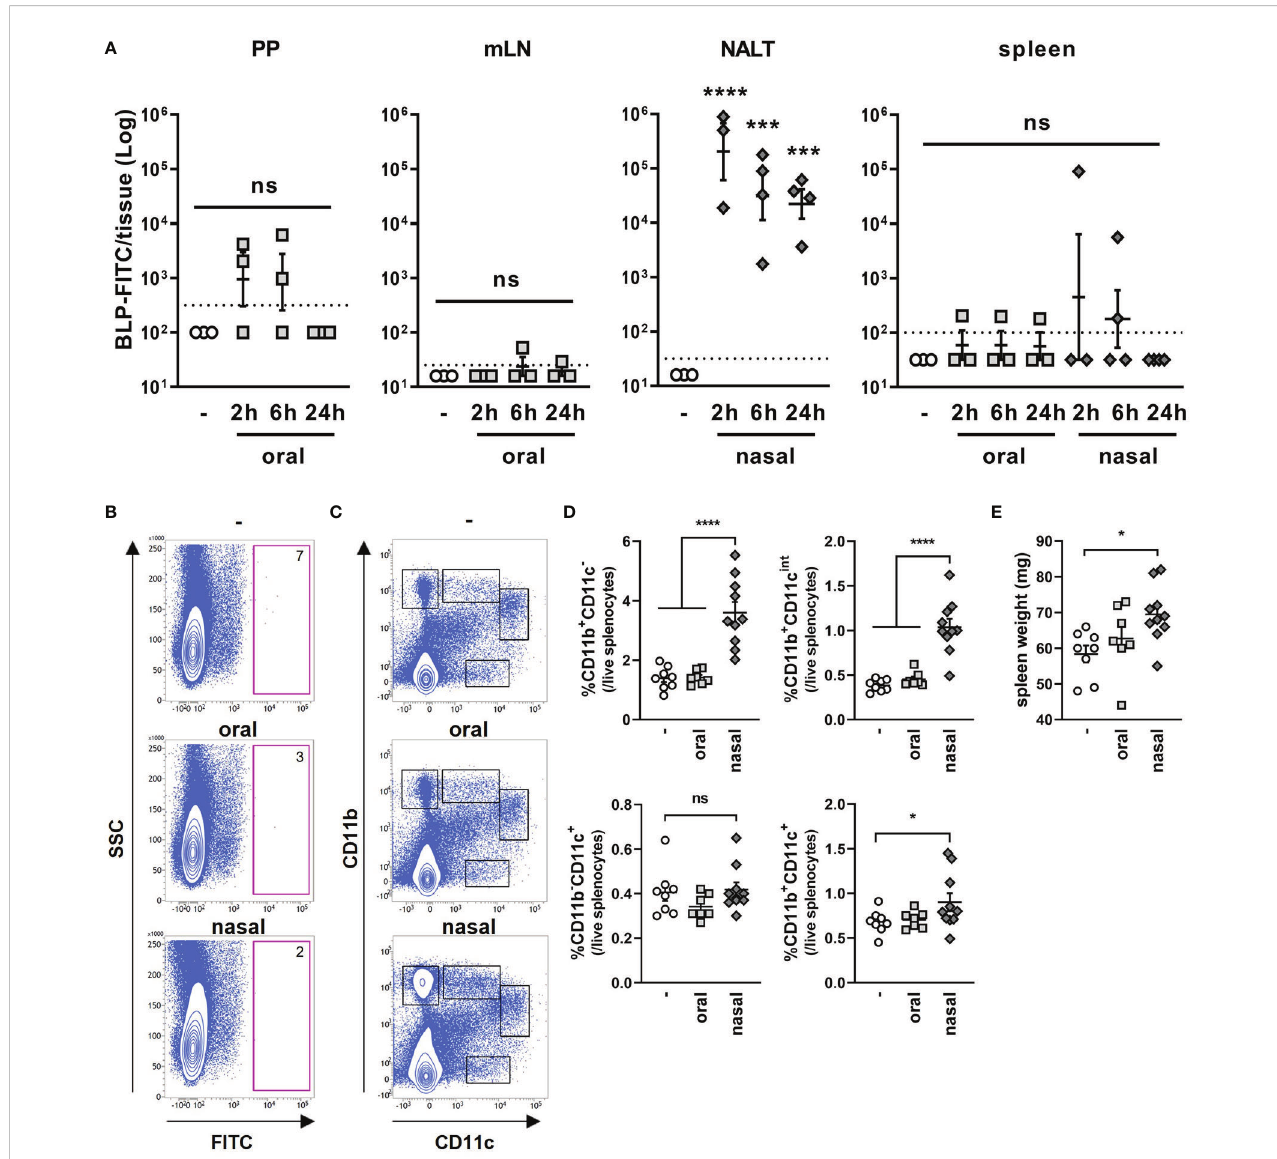
FIGURE 4 Dynamics of BLPs after oral and nasal administration. (A) The number of BLP-FITC conjugates in lymphoid tissues (PPs, mLNs, NALT and spleen) was determined by fl ow cytometry at 2, 6, or 24 h after oral or nasal administration of 2 × 10 9 BLP-FITC. Data were expressed as the mean ± SEM (n=3-4). Each symbol represents an independent mouse. Dotted line indicates the detection limit. ***, p<0.001; ****, p<0.0001; one-way ANOVA followed by Tukey ’ s multiple comparison test. (B) Splenocytes were isolated at 6 h after the oral or nasal administration of BLP-FITC. Dead cells were gated out with FVD780 reagent. Representative images of each group are shown (n=3-6). The red frame boxes indicate the number of FITC + cells in approximately 5 × 10 5 live splenocytes. (C) Splenocytes isolated at 24 h after the oral or nasal administration of BLP-FITC were stained with antibodies to CD11b and CD11c. Dead cells were gated out with FVD780 reagent. At least 2.5 × 10 5 live singlet cells were initially gated. Representative images of each group are shown (n=7-10). (D) Percentage of the populations is indicated with boxes in (C) . *, p<0.05; ****, p<0.0001; ns, not signi fi cant; one-way ANOVA followed by Tukey ’ s multiple comparison test. (E) Spleen weight of mice at 24 h after the oral or nasal administration with BLP-FITC. *, p<0.05; one-way ANOVA followed by Tukey ’ s multiple comparison